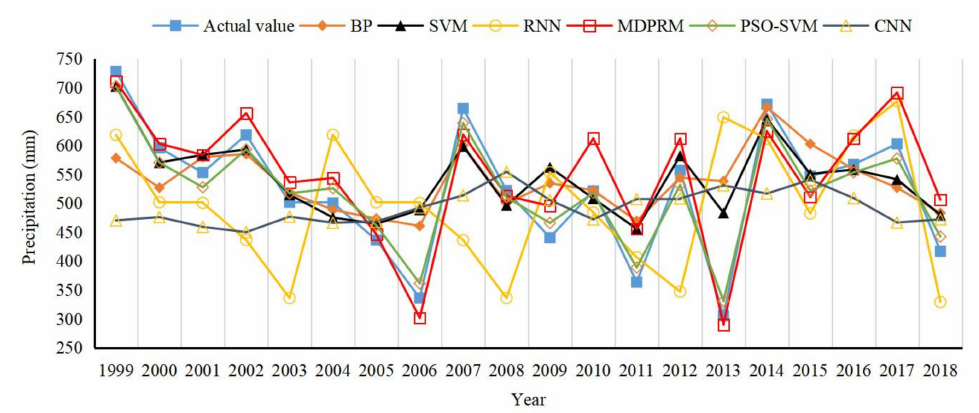
Figure 10. Comparison of summer precipitation test results in the Wujiang River basin from 1999–2018.